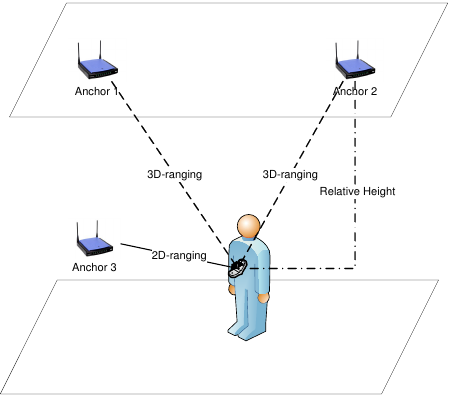
Figure 1. Demonstration of